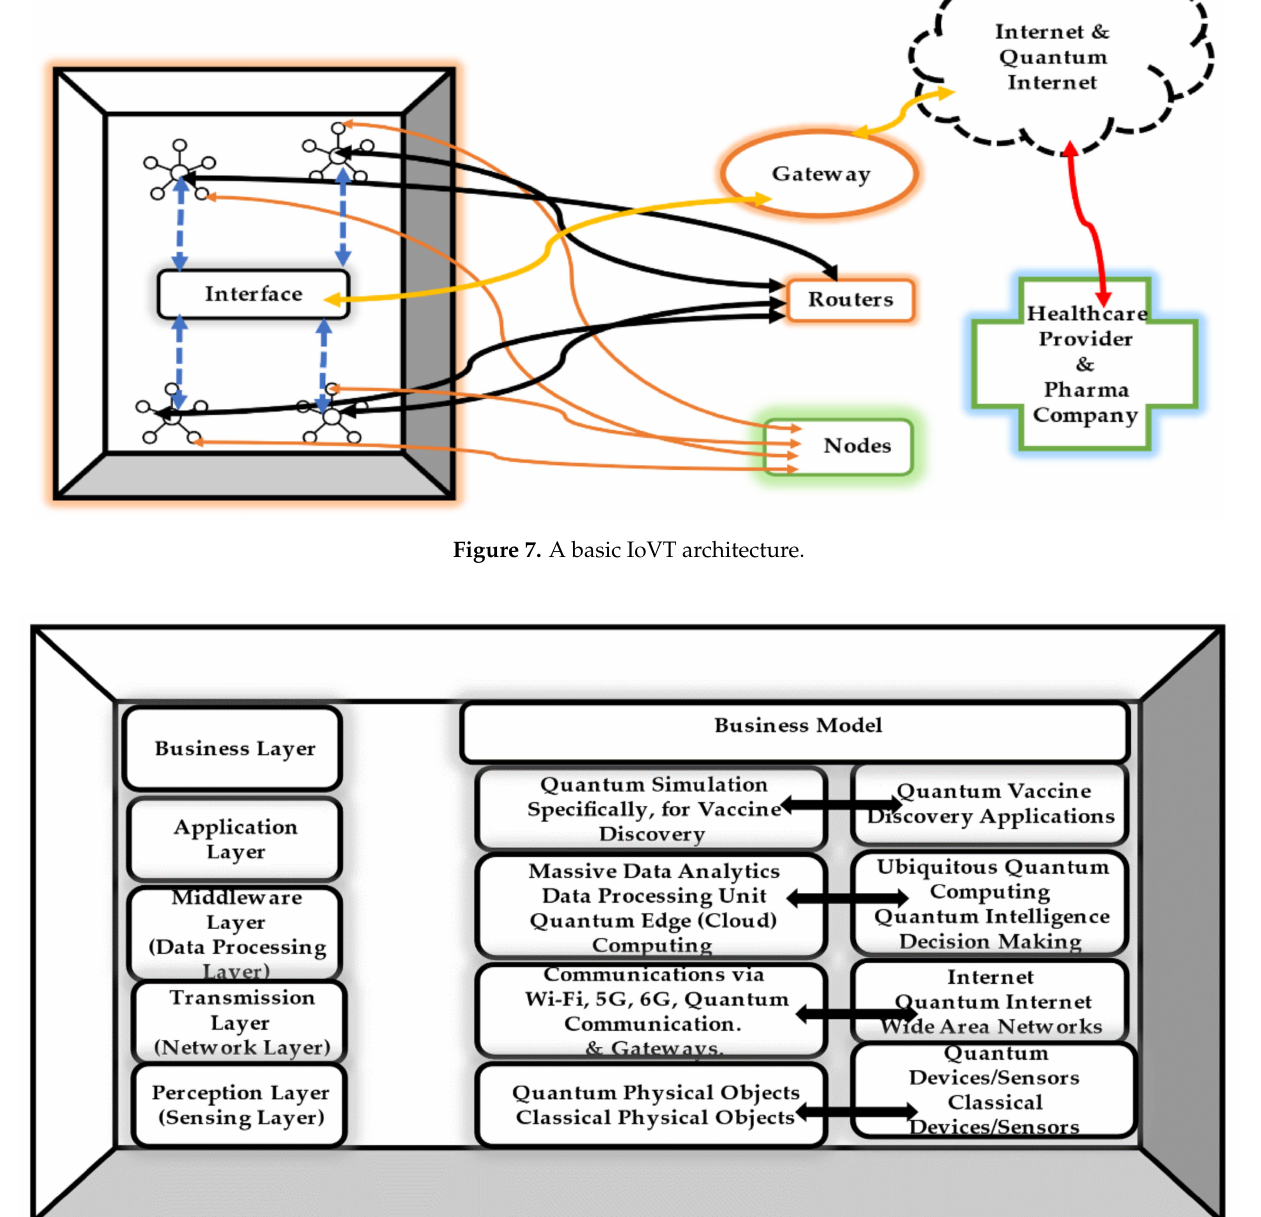
Figure 8. QBIoVT architecture layers and